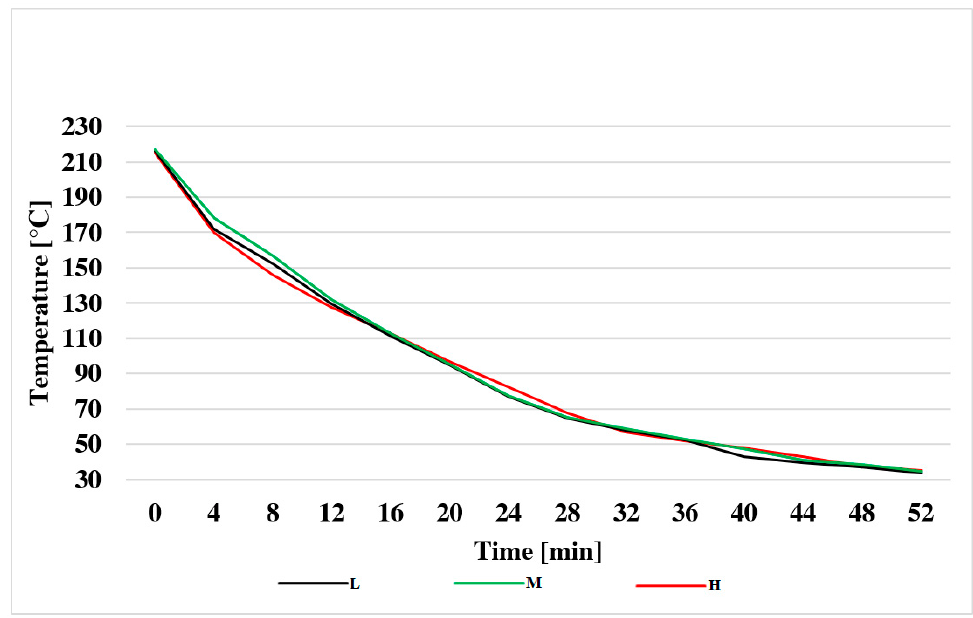
Figure 16 . Brake pads’ temperature in the section of contact with the brake cylinder . The brake pads in the section of contact with the brake cylinder had almost the same values while cooling (Figure